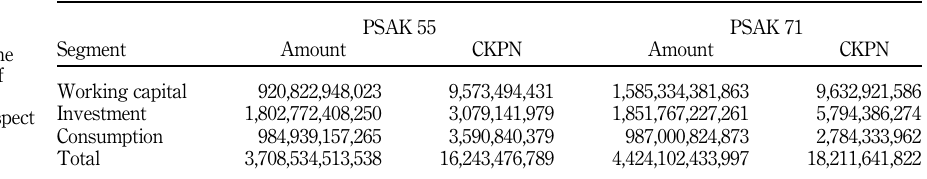
Table VII. Gap analysis of the implementation of PSAK 71 against PSAK 55 with respect to the formation of